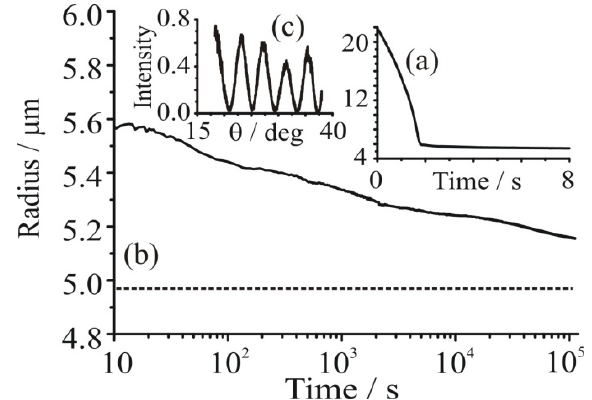
Fig. 7. (a) Initial loss of water on injection of a dilute aqueous HIO 3 droplet into a dry atmosphere within the concentric cylindrical elec- trodynamic balance. The gray dashed horizontal line indicates the estimated dry size for a crystal of HIO 3 (4.95±0.15µm). (b) in- dicates the size decrease over ∼ 33 h. (c) is a representative phase function observed after 70000 s indicating the droplet remained ap- proximately spherical.